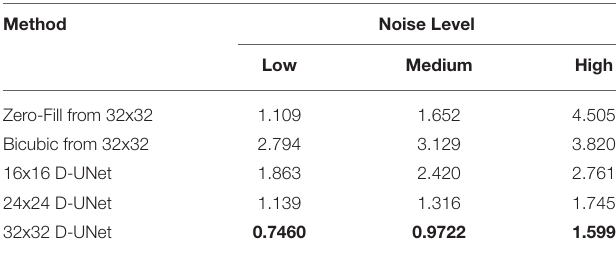
TABLE 1 | The mean squared error between the high resolution ground truth (HRSI) and several methods are tabulated.